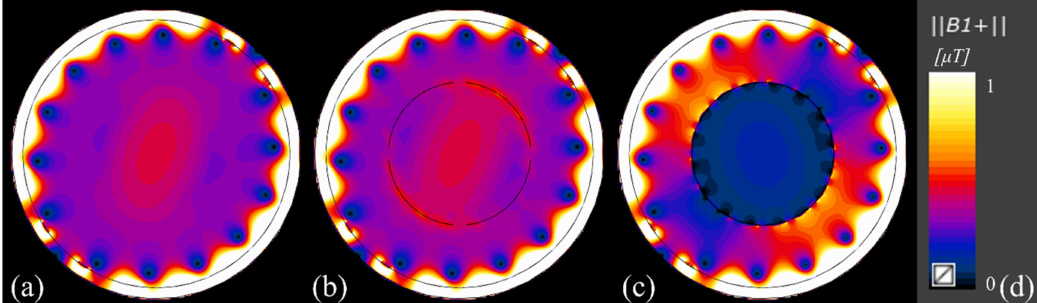
Figure 4. Calculated B + maps using Sim4Life. ( a ) B + map of body coil with a uniform fat phantom without a 13 C RF coil. 1 1 ( b ) B + map of body coil with uniform phantom with 16-leg PFT 13 C birdcage RF coil containing CPSCs showing almost 1 similar B + map as ( a ). ( c ) B + map of body coil with uniform phantom with 16-leg 13 C birdcage RF coil without CPSCs 1 1 map. The B + fields in ( a – c ) follow the color bar which is depicted in ( d showing degraded B + 1 1